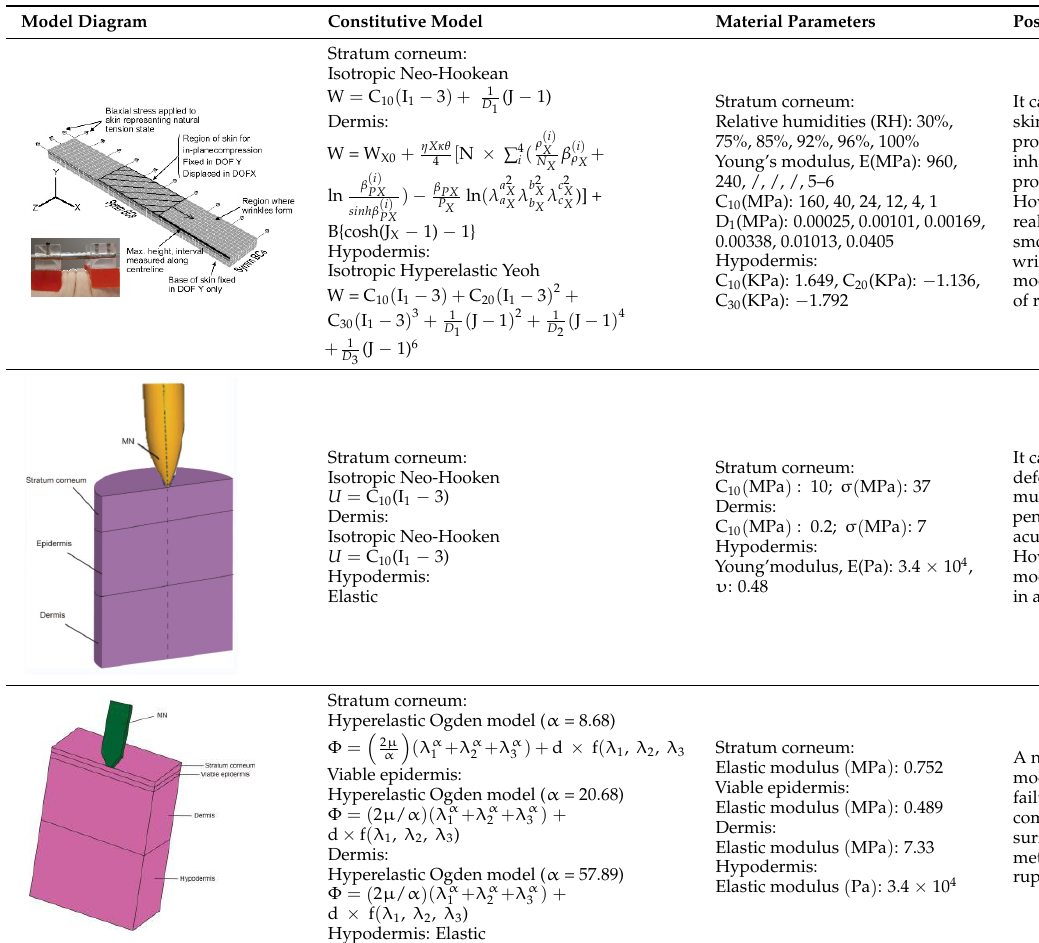
Stratum corneum: Stratum corneum: Hyperelastic Ogden model (α = 8.68) Hyperelastic Ogden model ( α =